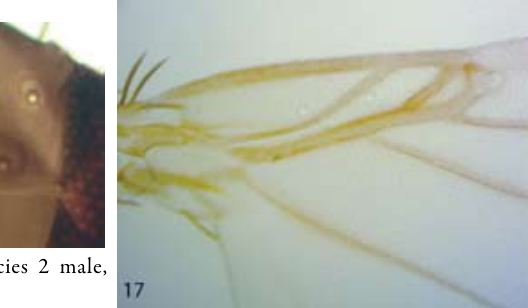
Figs 14-15. Rhynchomicropteron species 2 male, hypopygium. Fig. 14. Right face; Fig. 15. Left face. (Scale bar=0.1mm).